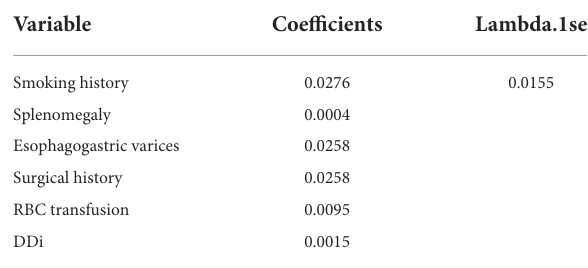
TABLE 3 Least absolute shrinkage and selection operator regression coefficient table.